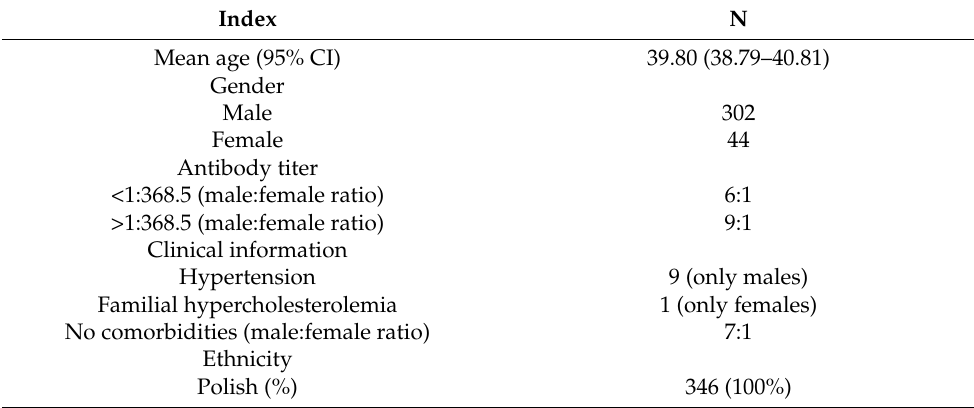
Table 1. Demographic